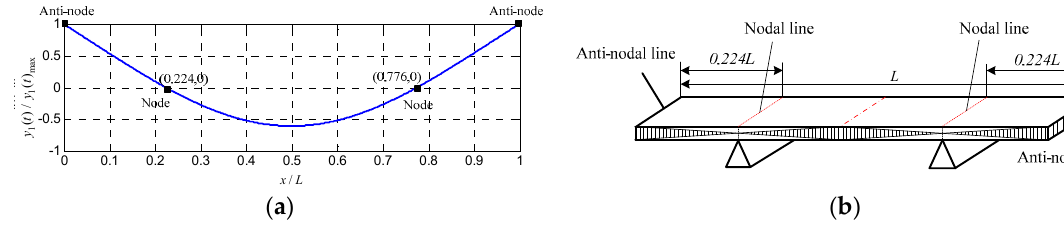
Figure 3. ( a ) Normalized 1st-order mode vibration of a free-free rectangular specimen; and ( b ) mechanical support for achieving 1st-order vibration.